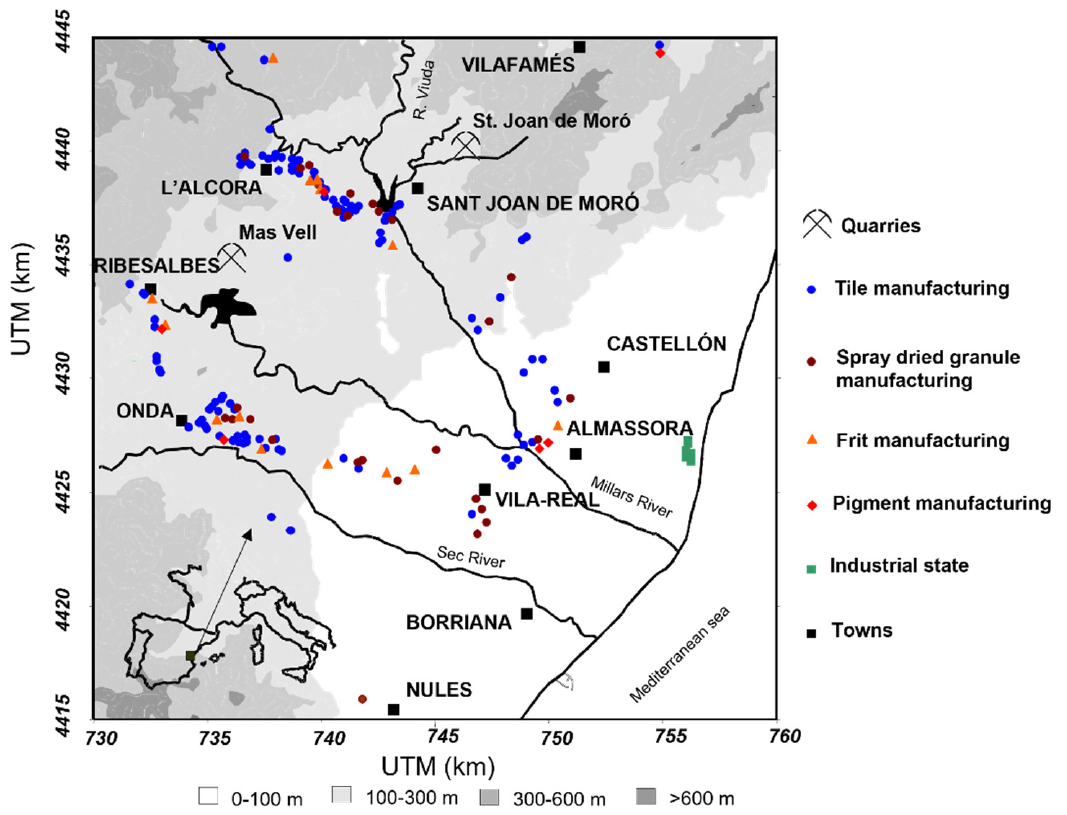
Figure 2. Map of the Castelló ceramic cluster [59].